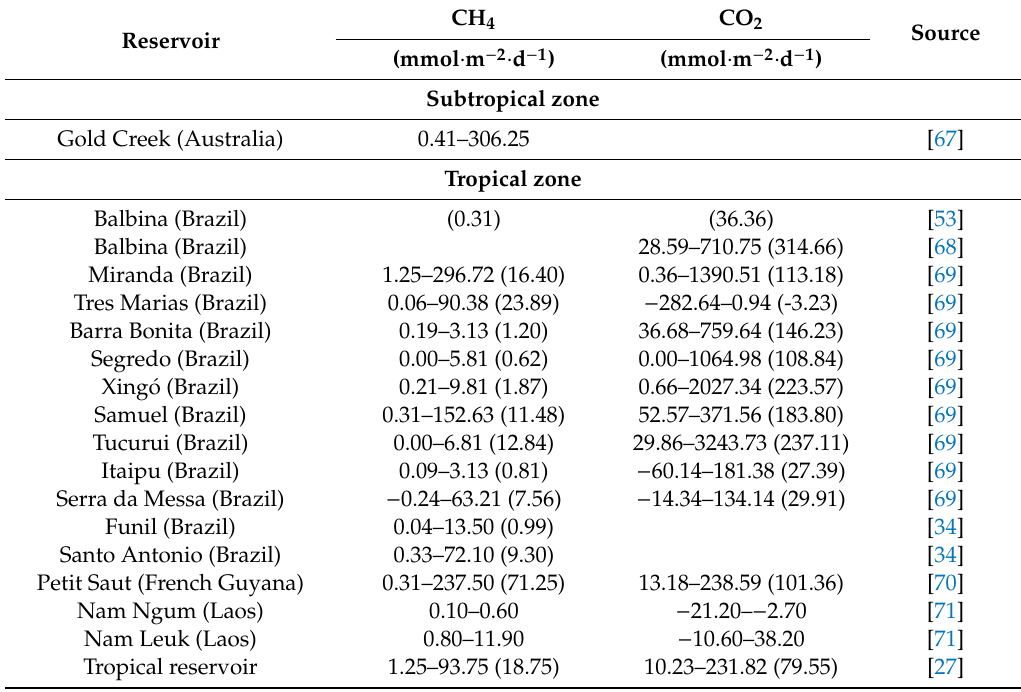
Table 4. Review of CH 4 and CO 2 fluxes from subtropical / tropical reservoir; mean values are given in brackets.